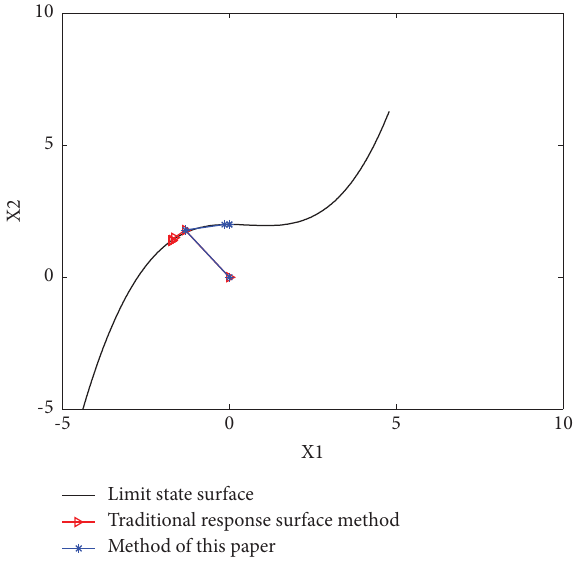
Figure 5: Iterative process of example 2.